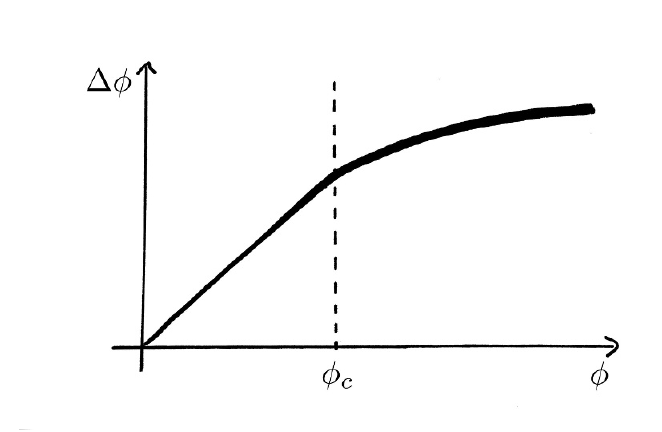
Figure 1 . Behaviour of the proper (cid:12)eld distance at large